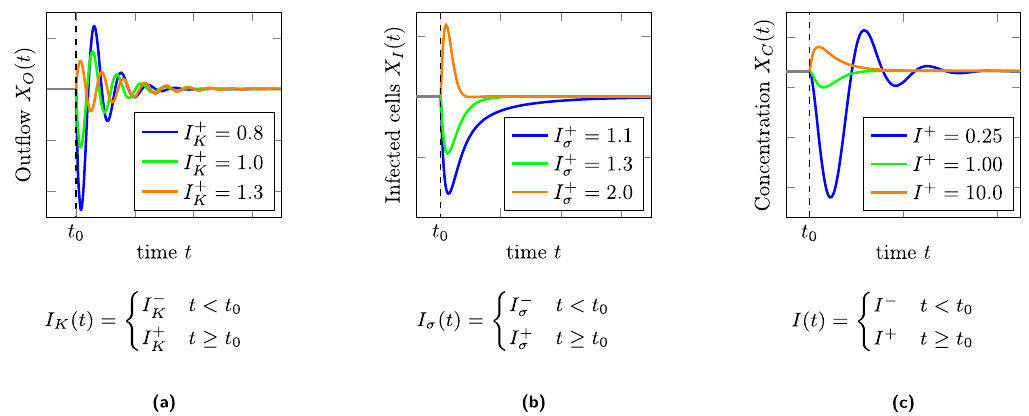
Figure 3: Simulations of the out fl ow rate X t O ( ) in the bathtub model ( a ) , the amount of infected cells X t I ( ) in the viral infection model ( b ) , and the concentration X t C ( ) in the biochemical reaction network with a negative feedback loop ( c ) . The input signal suddenly changes from a ( constant ) value for t t 0 < to a di ff erent ( constant ) value for t t 0 ≥ . The timing of this change is indicated by a vertical dashed line. The three systems started with input signals I 1.2 K − = , I 1.6 σ − = , and I 1.5 − = , respectively. After a transient response, X t X t , O I ( ) ( ) , and X t C ( ) all converge to their original equilibrium value ( i.e., they perfectly adapt to the input signal )